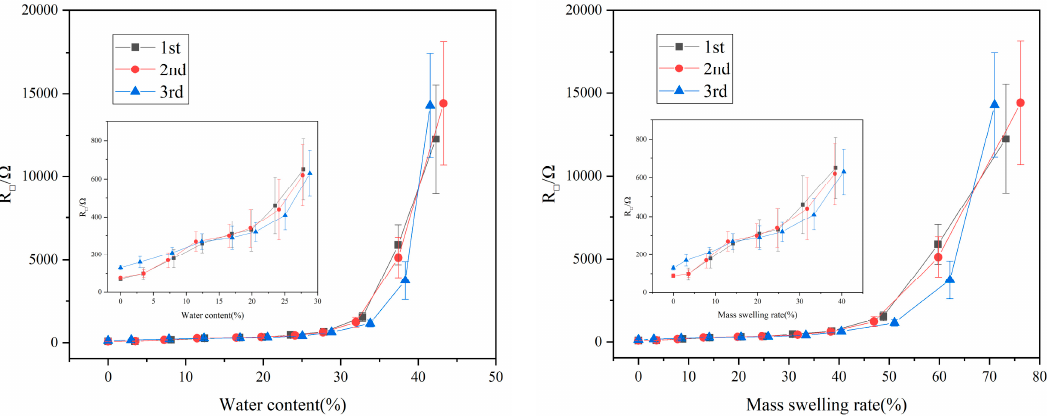
Figure 6. Relationship between water content/mass swelling rate and R □ of the SF/GrP/BD film repeatedly absorbing moisture three times.